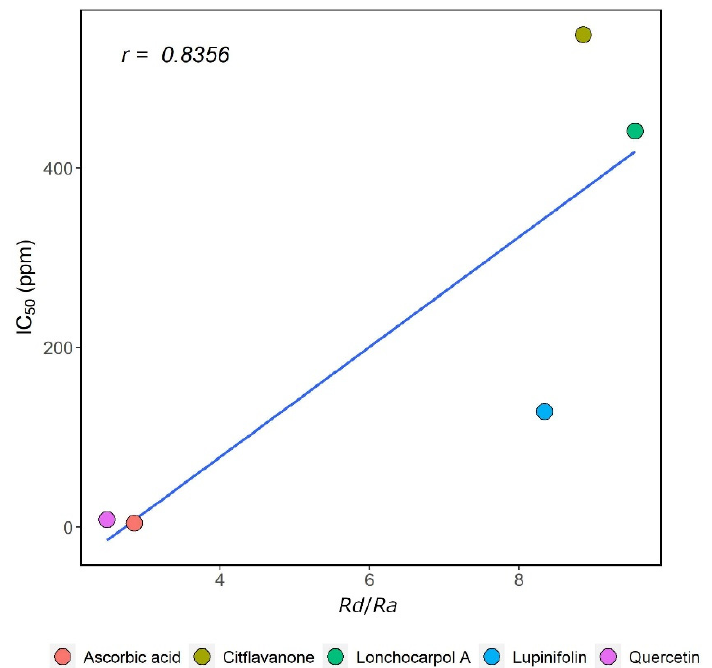
Figure 6. Pearson correlation coefficient between the results of in silico and in vitro studies (Table S1).